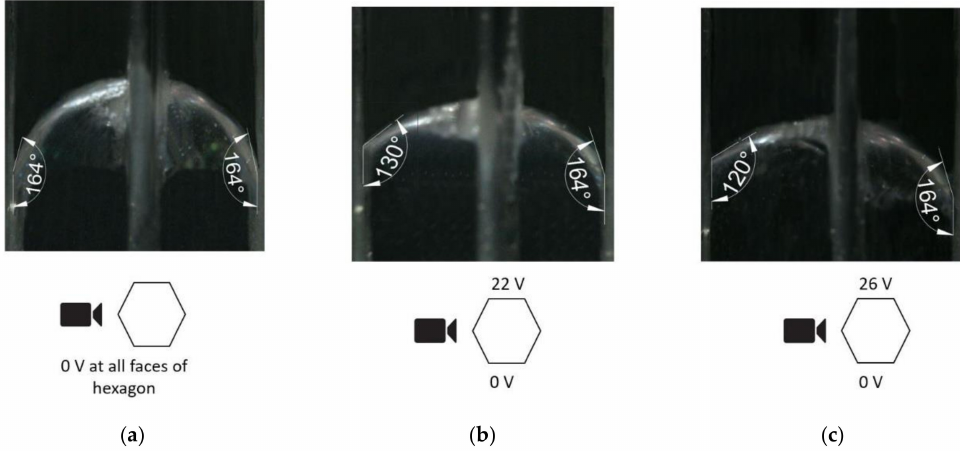
Figure 9. Liquid-liquid interface angle change, ( a ) 0 V, ( b ) 22 V, and ( c ) 26 V applied to the cell’s left electrode face.